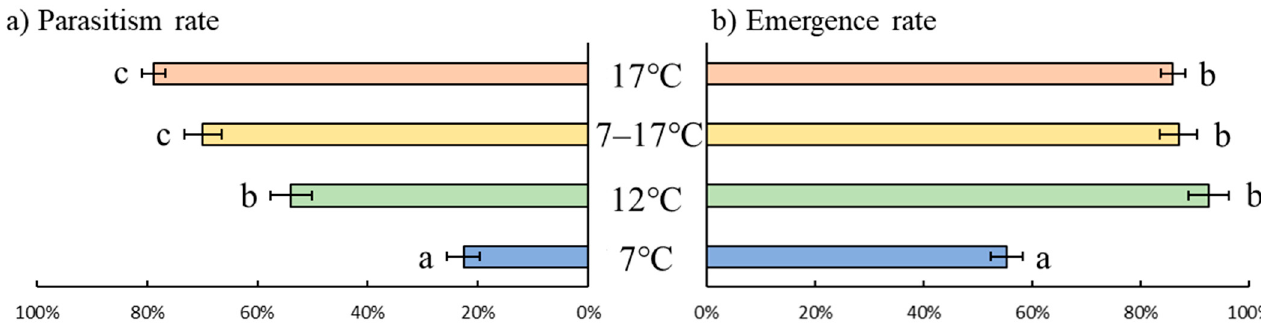
Figure 1. Parasitism rates ( a ) and emergence rates ( b ) of Aphidius matricariae parasitoids reared on Dysaphis plantaginea at three constant temperature regimes (7 °C, 12 °C, and 17 °C) and one fluctuating temperature regime (7–17 °C). Lowerscript letters indicate significant differences ( p < 0.05) among temperature regimes for each measured parameter. N = 10.